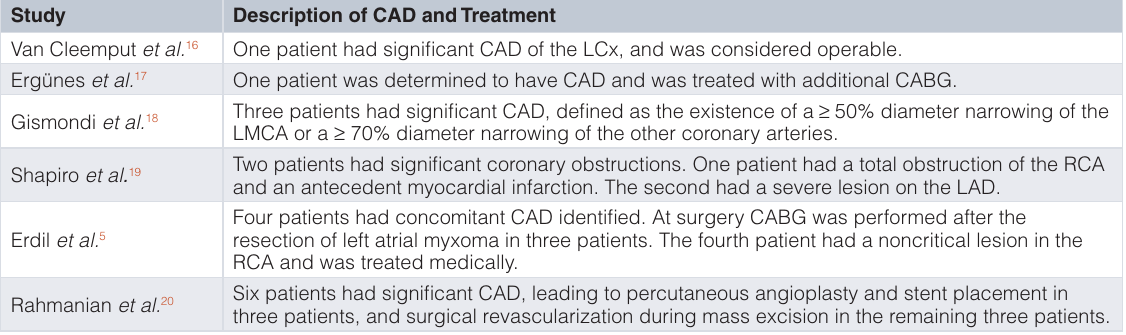
Table II. Description of CAD patients in each individual study and associated treatment when